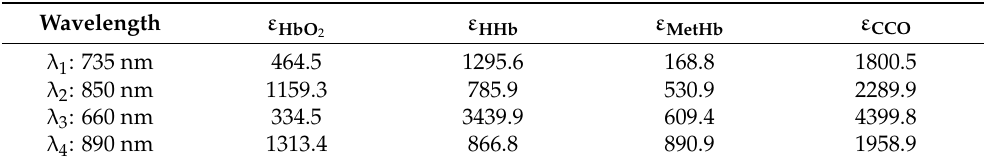
Table 1. Molar extinction coefficient extracted from Figure 8. Molar extinction coefficient is expressed in OD/M/cm (HbO 2 : oxygenated hemoglobin, HHb: deoxygenated hemoglobin, MetHb: methemoglobin, CCO: cytochrome aa3). Wavelength ε HbO 2